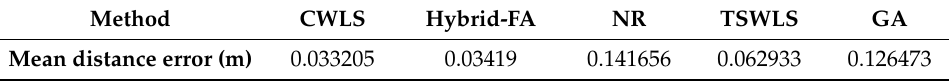
Table 2. The mean distance error of different methods.